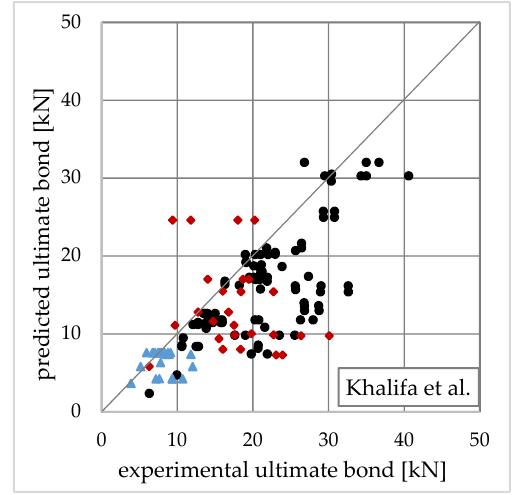
Figure 12. Test vs. predicted bond force using the Khalifa et al. model [24].